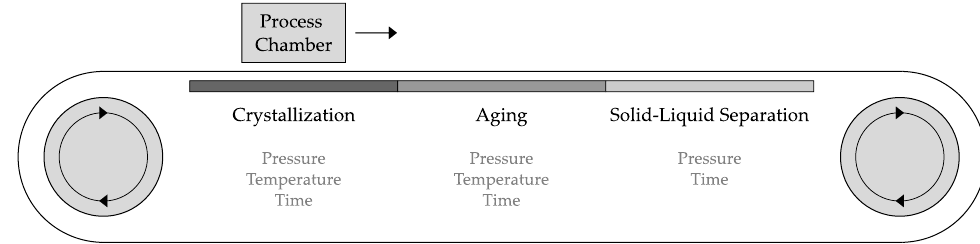
Figure 1. Concept of the enhanced belt crystallizer. The basis of the system is a belt filter, in which the vacuum trays below the filter medium are replaced by functional units. The plant includes the process steps crystallization, aging and solid–liquid separation. Key parameters are pressure, temperature and time.